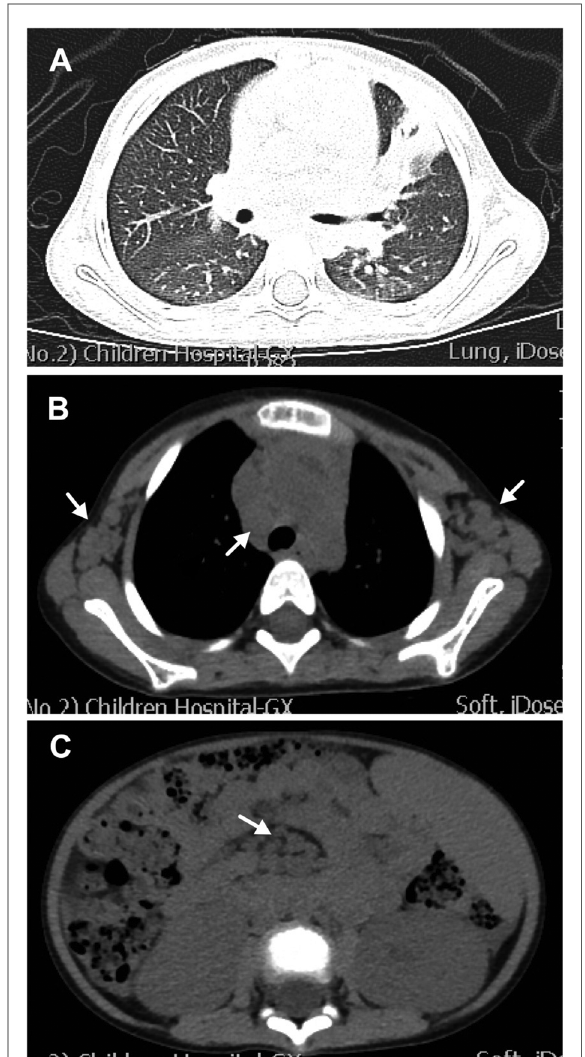
FIGURE 1 Computed tomography (CT) scanning of the chest and abdomen. ( A ) Lung CT scan showing scattered ground-glass opacity in both lungs and consolidation in the left lung. ( B ) Lung CT scan showing enlargement of multiple lymph nodes on the axillae and mediastinum (white arrows). ( C ) Abdominal CT scan showing enlargement of multiple lymph nodes (white arrows) and enlarged spleen and